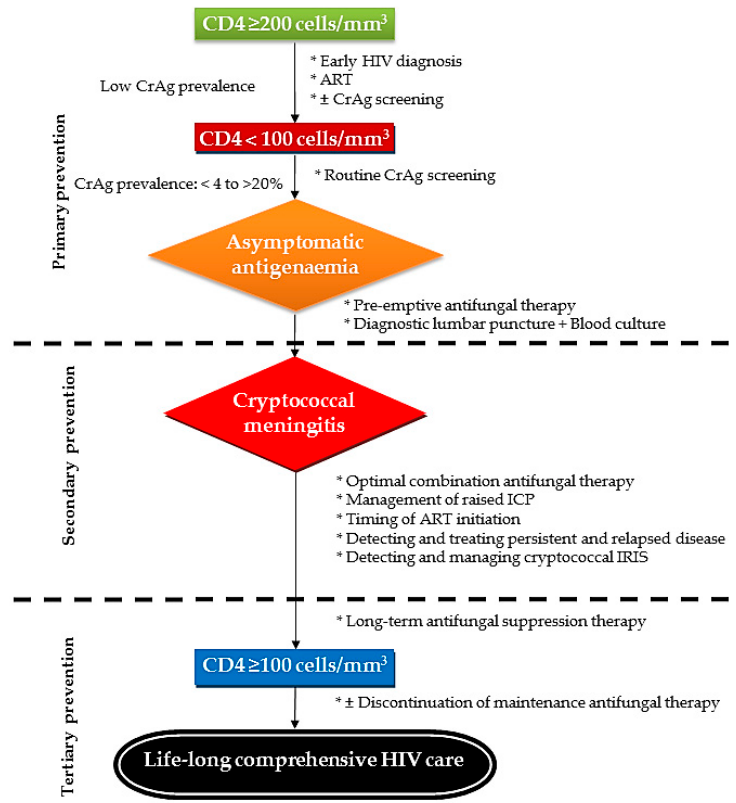
Figure 3. Levels of prevention for cryptococcal disease stratified by immunological status. CD: Cluster of differentiation. IRIS: Immune reconstitution inflammatory syndrome. ICP: Intracranial pressure. ART: Antiretroviral therapy.